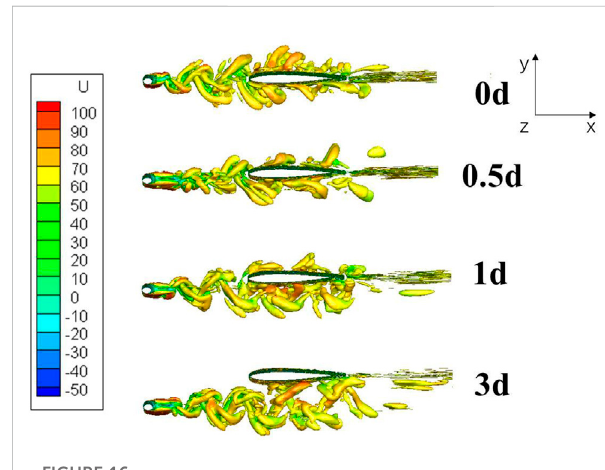
The overall Q-criterion iso-surface of different offset